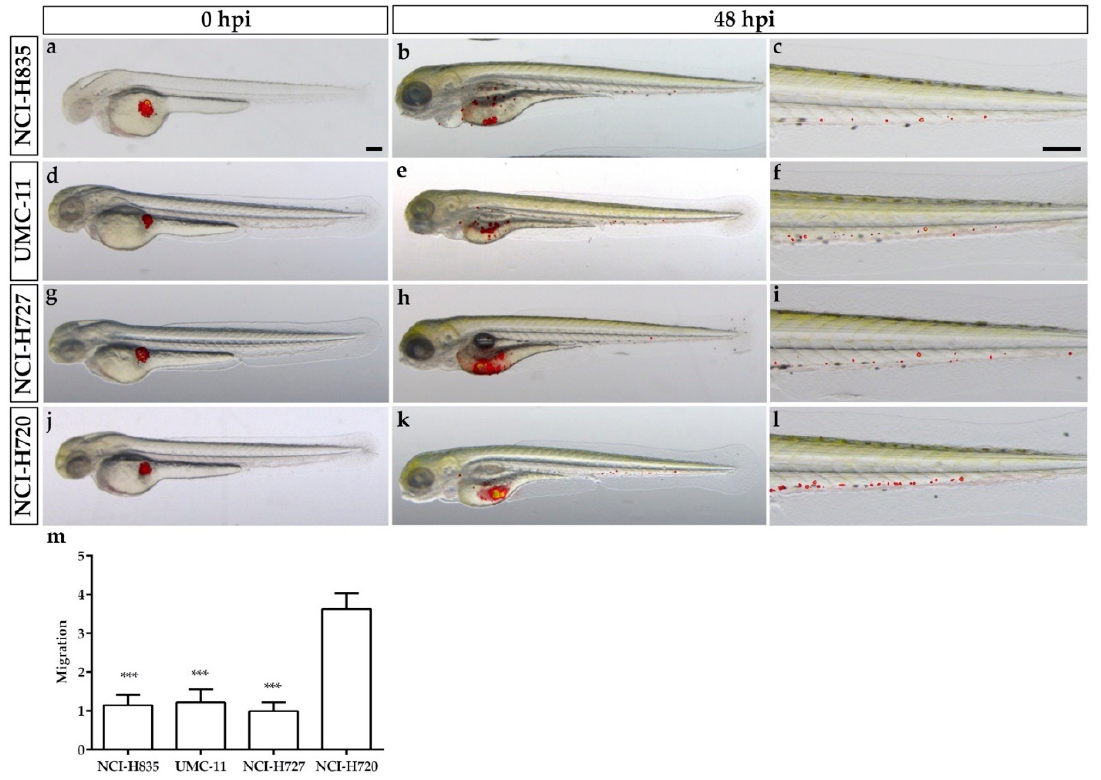
Figure 2. Lung carcinoid cell invasiveness in grafted zebrafish embryos. Overlay of representative fluorescent and bright field images of embryos grafted with red-stained NCI-H835, UMC-11, NCI- H727, and NCI-H720 cells at 0 ( a , d , g , j ) and 48 hpi ( b , e , h , k ), respectively. For each injected cell line, the tail, particularly at 48 hpi, was imaged ( c , f , i , l ). Images showed the spread of carcinoid cells throughout the embryo body. The graph showed the quantification of tumor cell migration in the tail of embryos implanted with lung carcinoid cells after 48 hpi ( m ) . As an arbitrary unit of migration, we considered the number of fluorescent particles in the tail. NCI-H727 values have been set to 1.0. Graphed values represent the mean ± S.E.M. *** p < 0.001 vs. NCI-H720. Embryos are shown anterior to the left. Scale bar: 100 µ